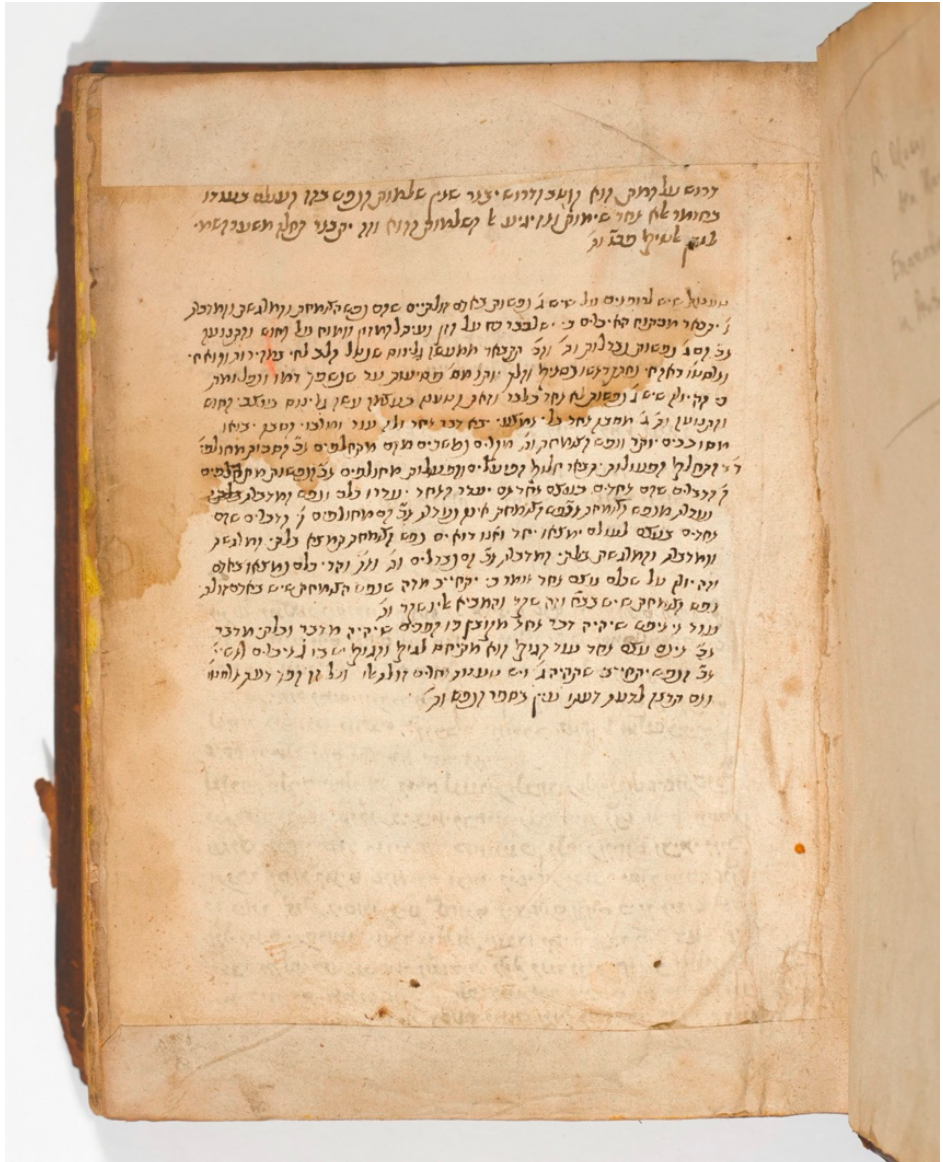
Figure 11. Handwritten notes in Commentary on the Torah, by Moses ben Nachman; Marsh’s Library C.3.1.26.